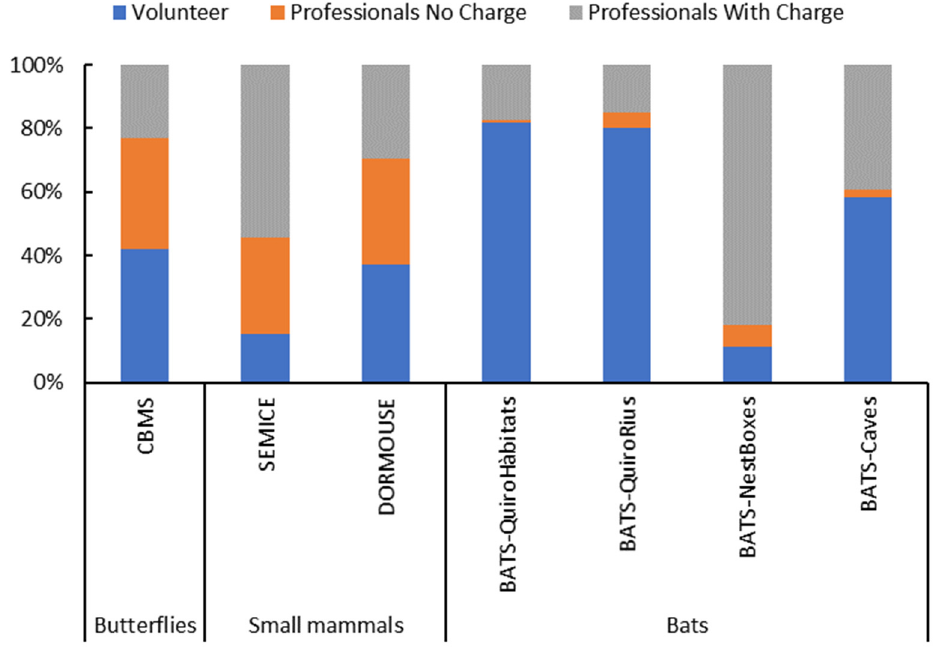
Figure 3. Contribution of the three classes of collaborators to the maintenance of the monitoring stations during the year 2020. stations during the year